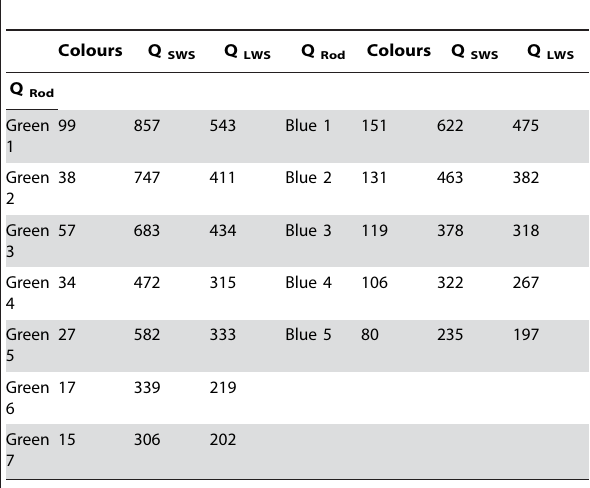
Table 2. Relative quantum catches for horse photoreceptors